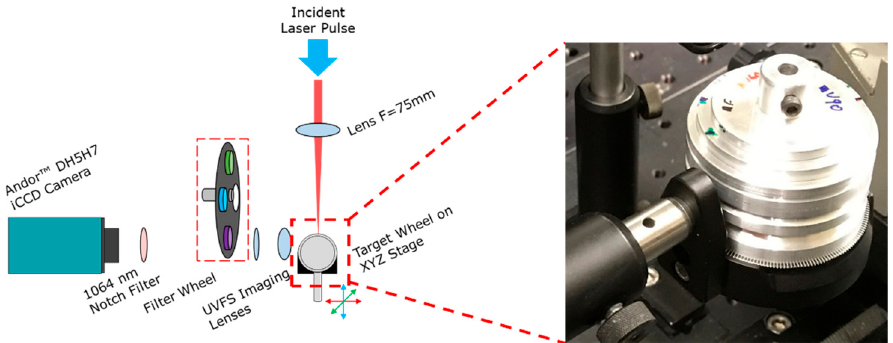
Figure 1. A schematic of the fast-imaging experimental setup along with a photograph of the V-channel target geometry. A plano-convex lens (F = 75 mm) was used to focus the laser beam onto the target. A pair of UV fused silica (UVFS) lenses with focal lengths 50 mm and 150 mm were applied in order to achieve a magnification 3×. Narrow bandpass filters were introduced via the filter wheel for the spectrally resolved measurements.